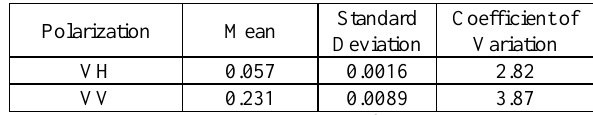
Table 1: Statistical values for sampled 𝛾 0 time series.